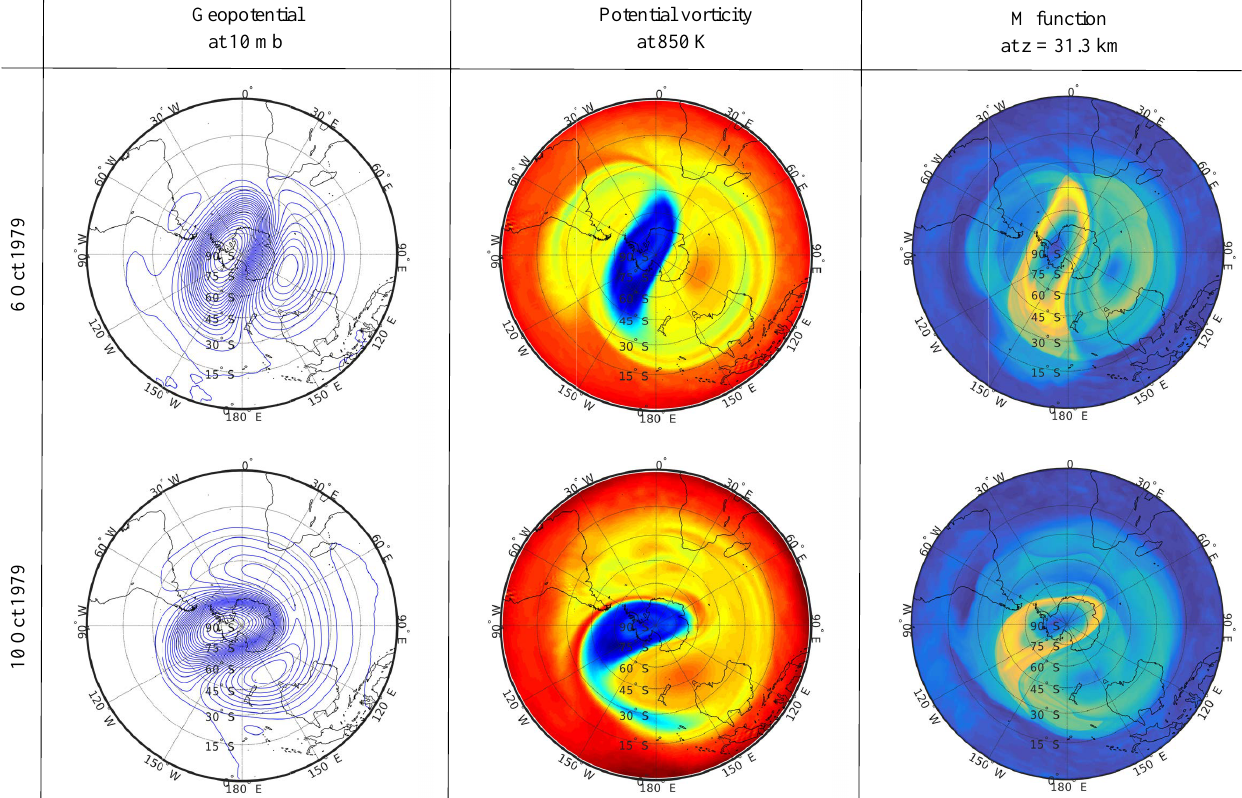
Figure 4. Comparison of geopotential at constant pressure 10mb, potential vorticity at 850K and M function at z = 31 . 3km for several days of October